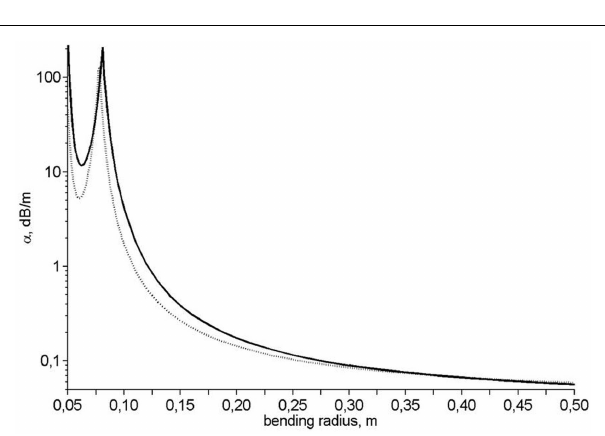
FIGURE 4 |The calculated transmission bands for ideal NCHCF (eight capillaries; D core = 223 µ m, d in / d out = 0.8) forAs 2 S 3 (solid line) and As 30 Se 50 Te 20 (dotted line) glasses (Shiryaev et al., 2014b) .